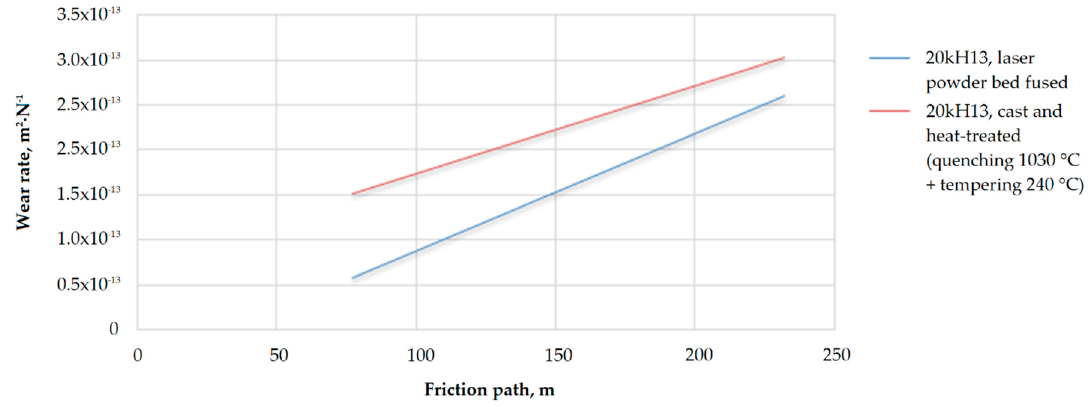
Figure 14. Dependence of the wear rate on the friction path of the 20kH13 (AISI 420) steel samples.